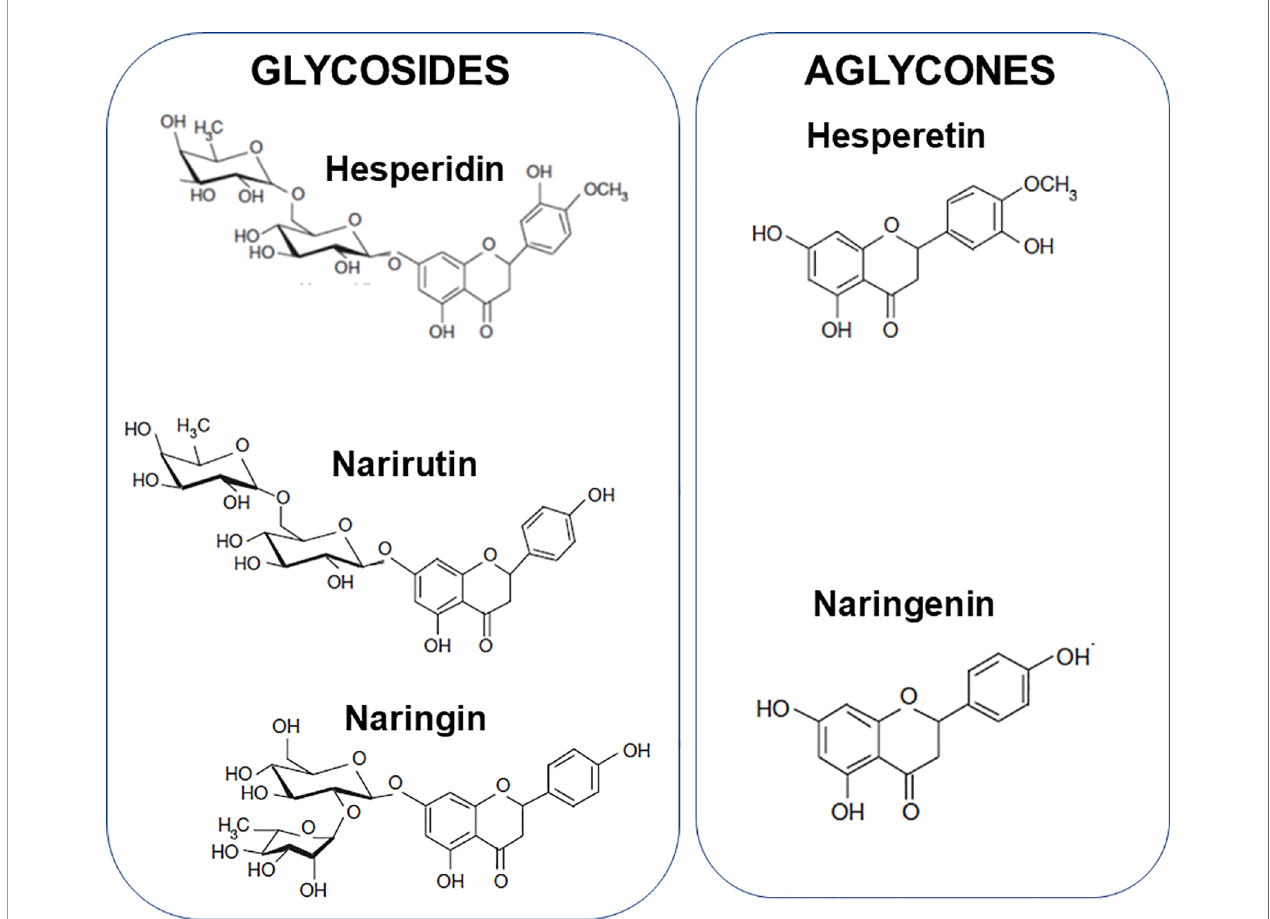
FIGURE 3 | Structure of hesperidin, narirutin and naringin and the aglycones hesperetin and